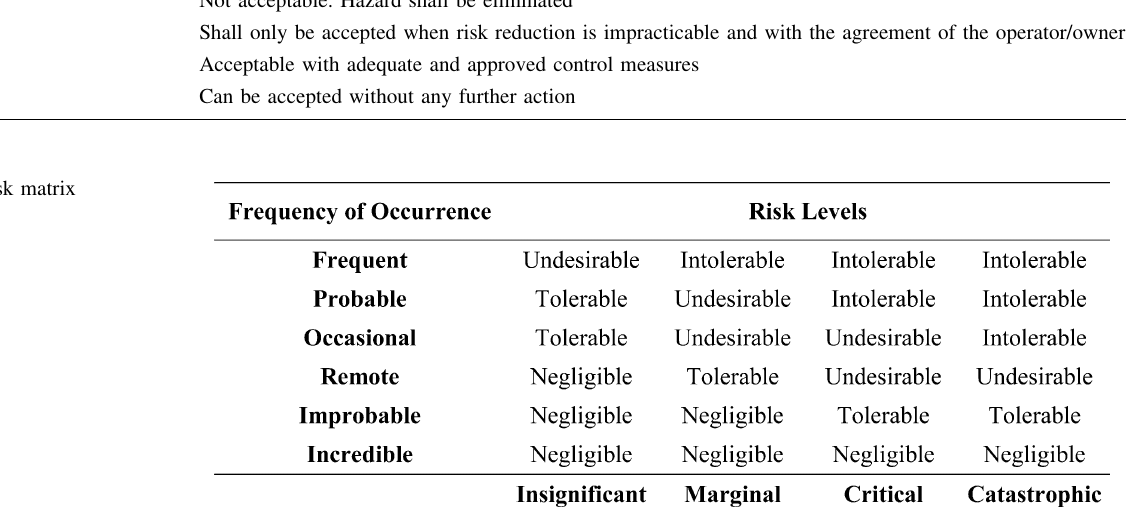
Table 2 Risk level defined in accordance with EN 50126/IEC 52278 Risk level Hazard reduction/control